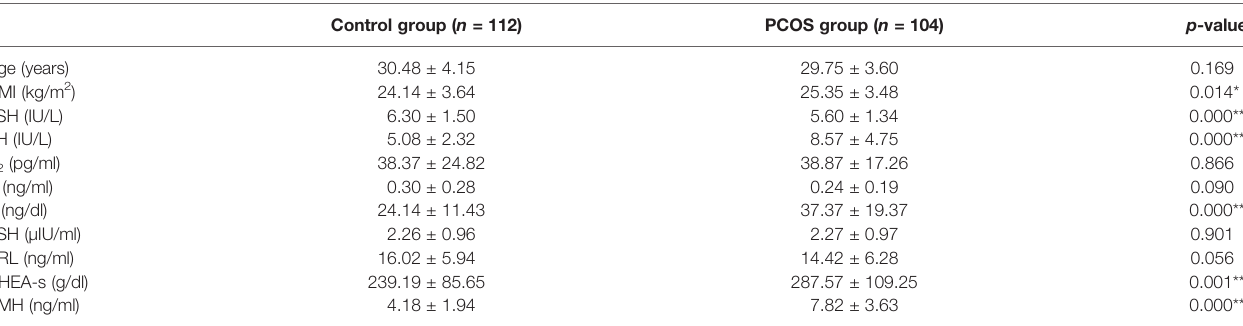
TABLE 1 | Baseline characteristics and hormones analysis of the population